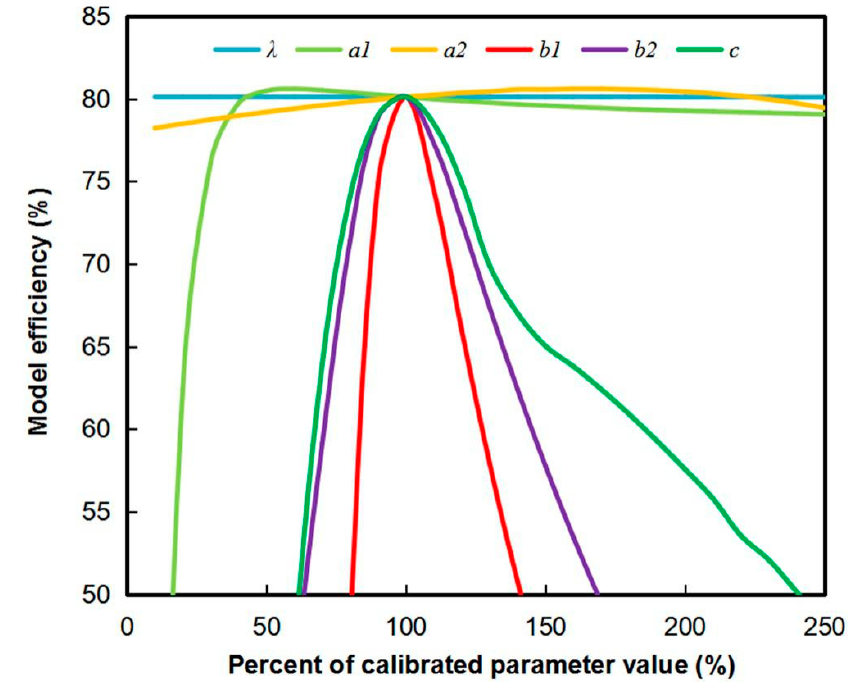
Figure 7. Sensitivity analysis of the empirical parameters of Method 2.